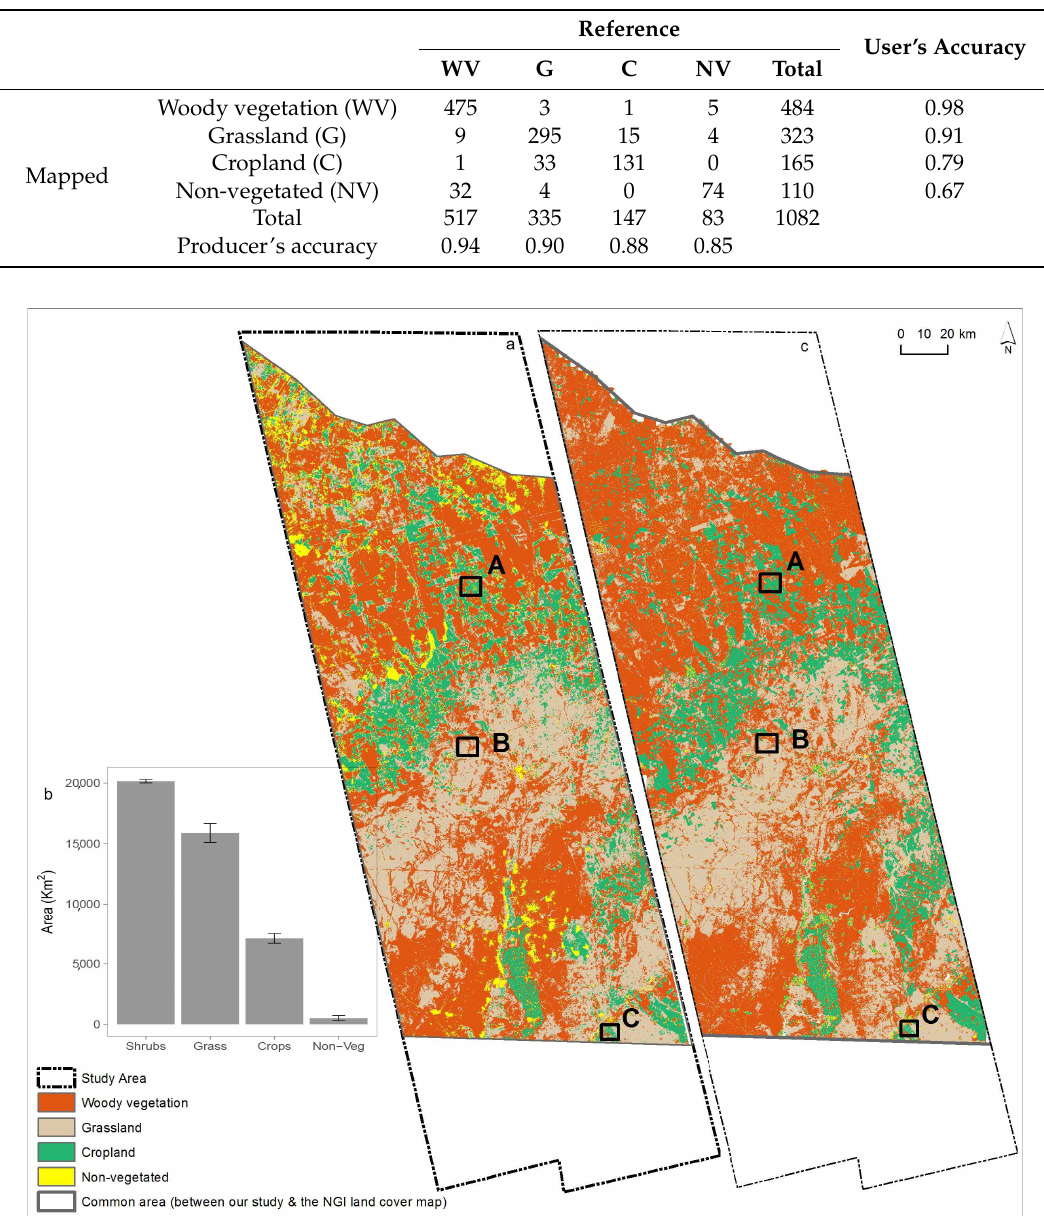
Table 4. Confusion matrix and accuracy statistics for the all-parameter model (Model #9 in Table 3).